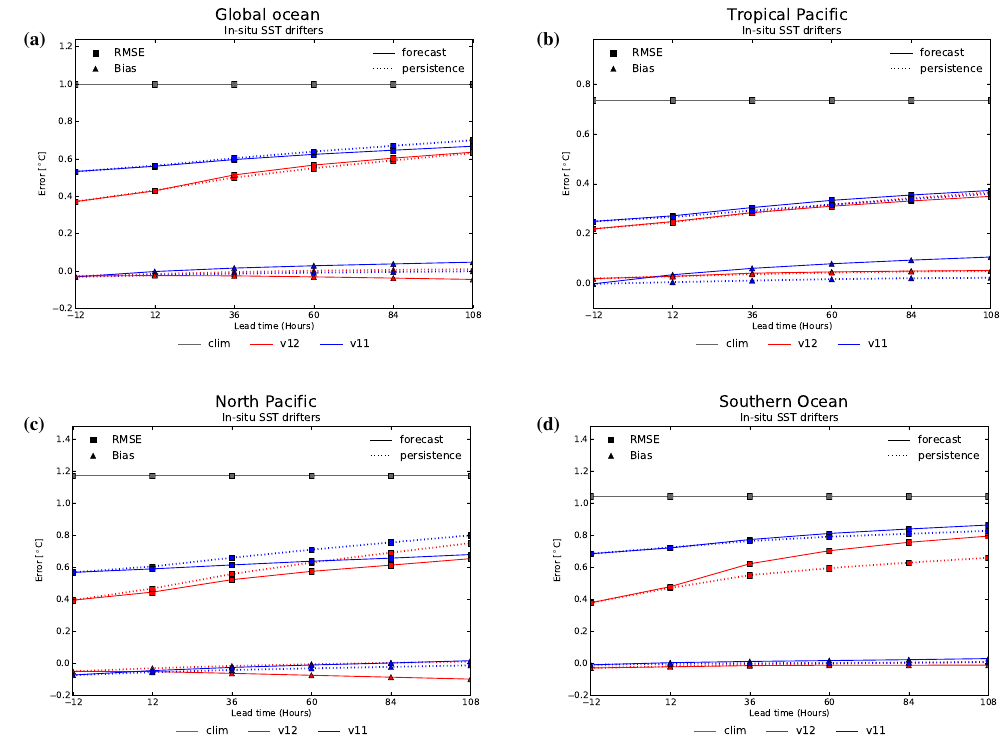
Fig. 6. Forecast lead-time plots showing RMS errors (squares) and mean errors (triangles) against surface temperature measurements ( ◦ C ) taken by in-situ drifting buoys for the (a) global, (b) Tropical Pacific, (c) North Pacific and (d) Southern Ocean regions. Statistics are shown for model forecasts (solid lines) and persistence (dotted lines) averaged over all forecasts performed during the trials for the v12 (red) and v11 (blue) systems and the EN3 climatology (grey). The x-axis represents forecast lead-time (in hours) ranging from the analysis fields at T-12h up to the 5-day forecasts at T+108h.